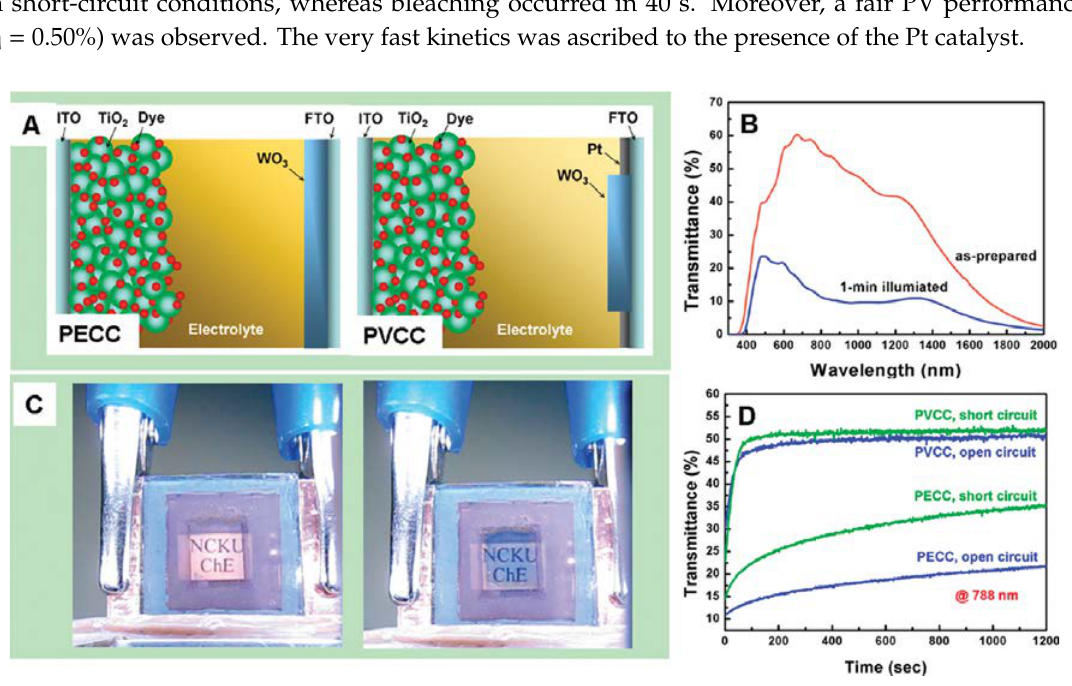
Figure 6. Device architectures of a typical photoelectrochromic device and of a photovoltachromic device ( A ); Transmittance spectra of the device in the bleached and colored state ( B ); pictures of the two states ( C ); transmittance spectra at 788 nm for a photoelectrochromic device and for a photovoltachromic device ( D ). “Fast-Switching Photovoltachromic Cells with Tunable Transmittance”, ACS Nano 2009,